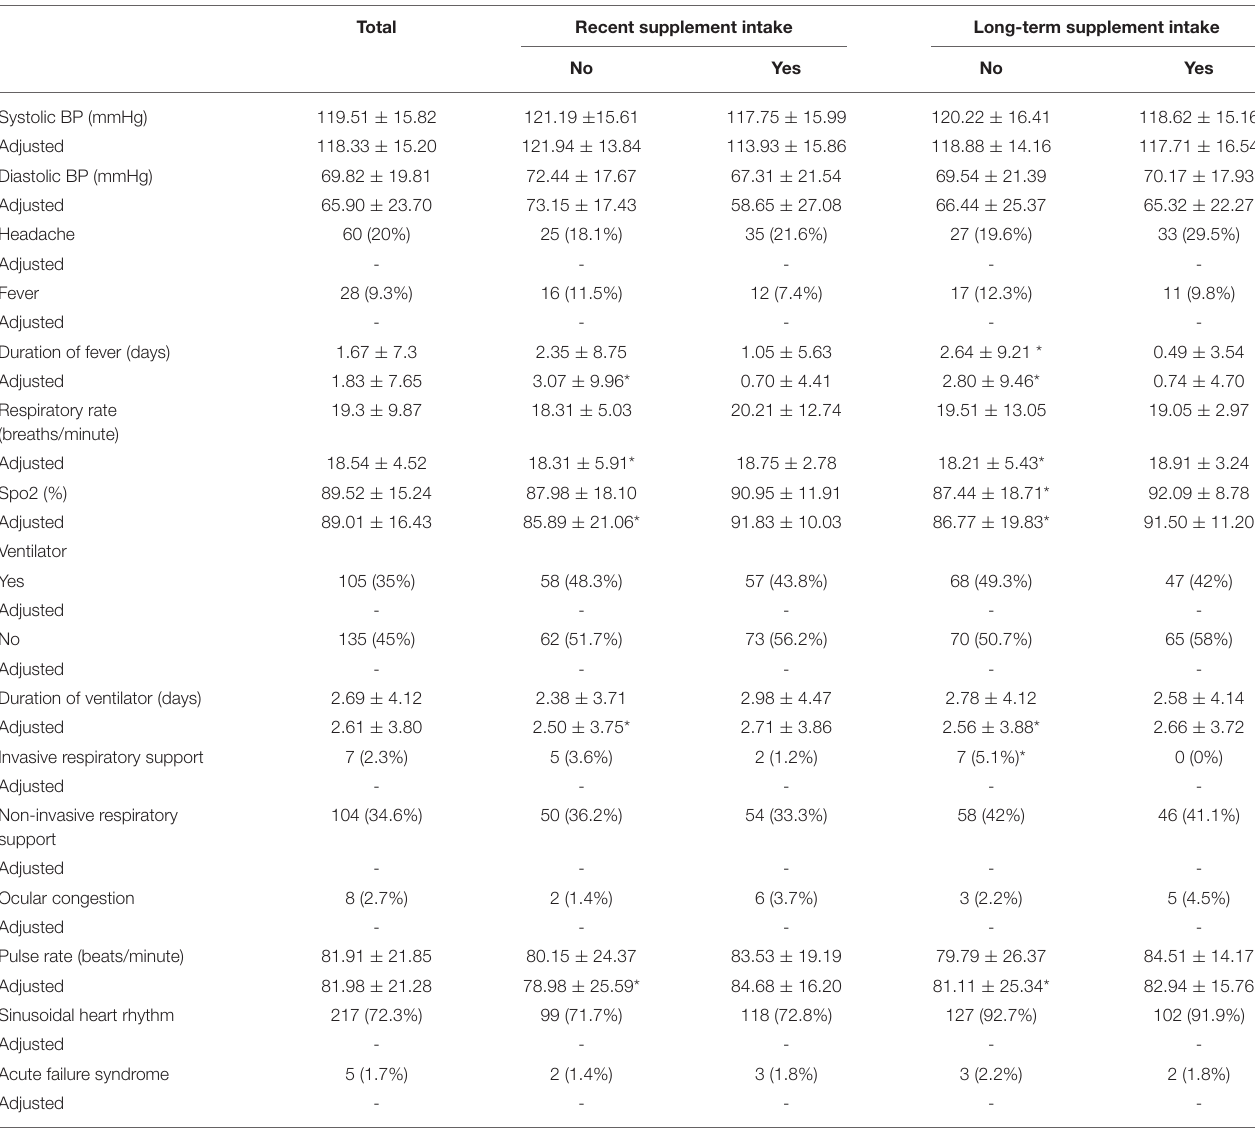
TABLE 4 | Clinical and paraclinical parameters in patients with COVID-19 in different supplement intake categories.